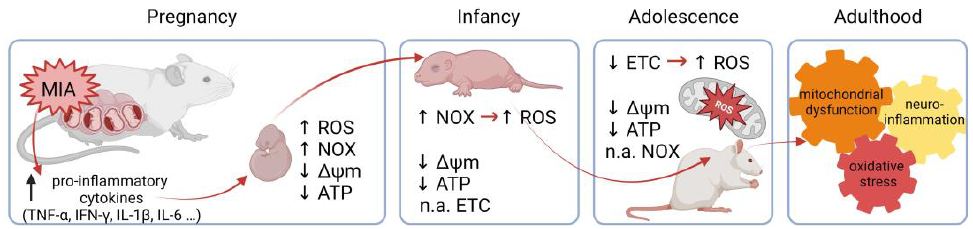
Figure 11. The proposed course of events. Activation of the maternal immune system induces the secretion of pro-inflammatory cytokines, affecting the developing fetus, through NOX activation and the induction of ROS generation. It is also accompanied by decreased ΔΨm and ATP levels. Increased NOX activity and ROS levels, as well as decreased ΔΨm and ATP levels, remain through infancy, but are not accompanied by a disturbance in ETC functioning, suggesting some compensatory mechanisms. High ROS levels persist until adolescence, but are no longer caused by NOX activity. An alternative source of ROS seems to be damaged mitochondria. Decreased ΔΨm and ATP levels, as well as the decreased expression and activity of ETC complexes, suggest OXPHOS dysfunction and mitochondrial damage. The accumulation of disturbed mitochondria and oxidative stress can lead to neuroinflammation and finally synaptic impairment throughout the life of an MIA individual. NOX—NADPH oxidase; ROS—reactive oxygen species; ΔΨm—mitochondrial mem-